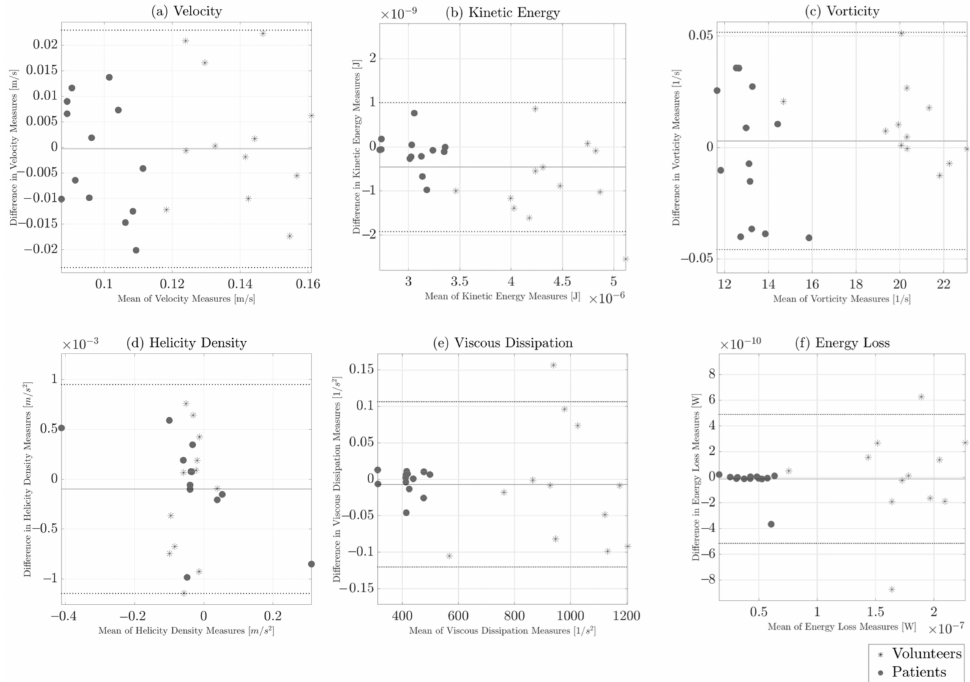
Figure A1. Bland-Altman plots represent the intra-observer reproducibility in the measurements of LV global hemodynamic parameters ( a – f ) at peak systole. The thick line represents the mean difference, and the thin lines represent the limits agreement (1.96